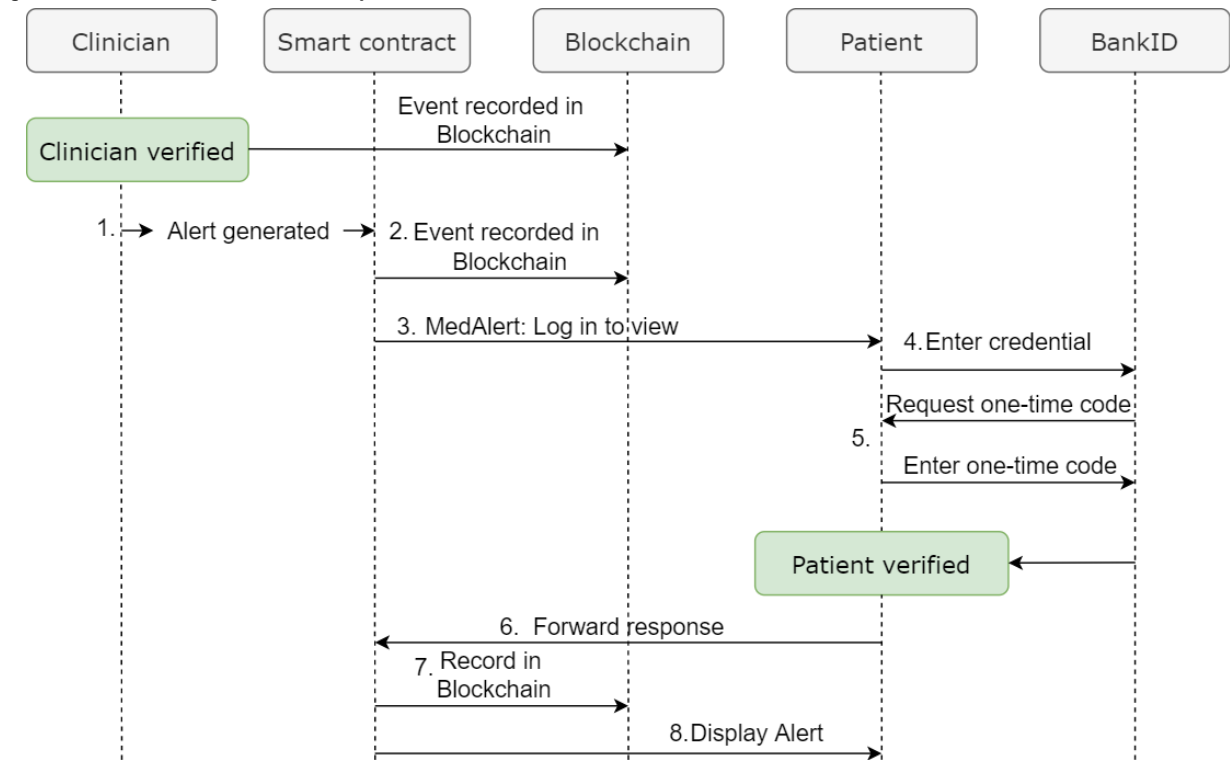
Figure 5. Workflow using BankID to verify and